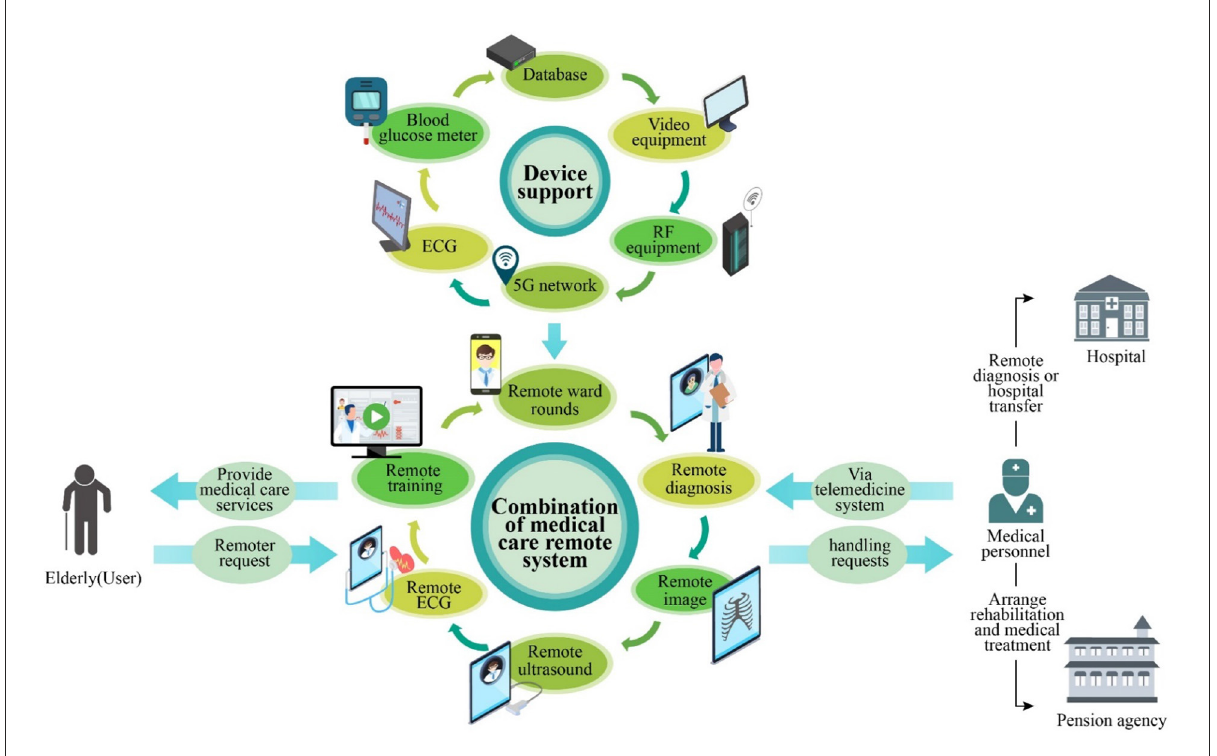
FIGURE9 CMEC telemedicine